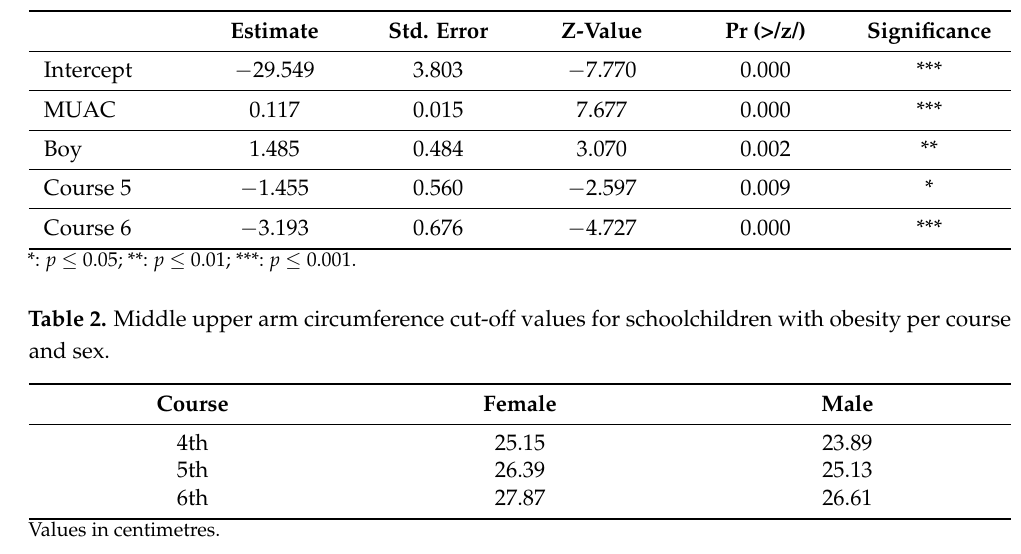
Table 1. Generalised linear model summary for obesity.